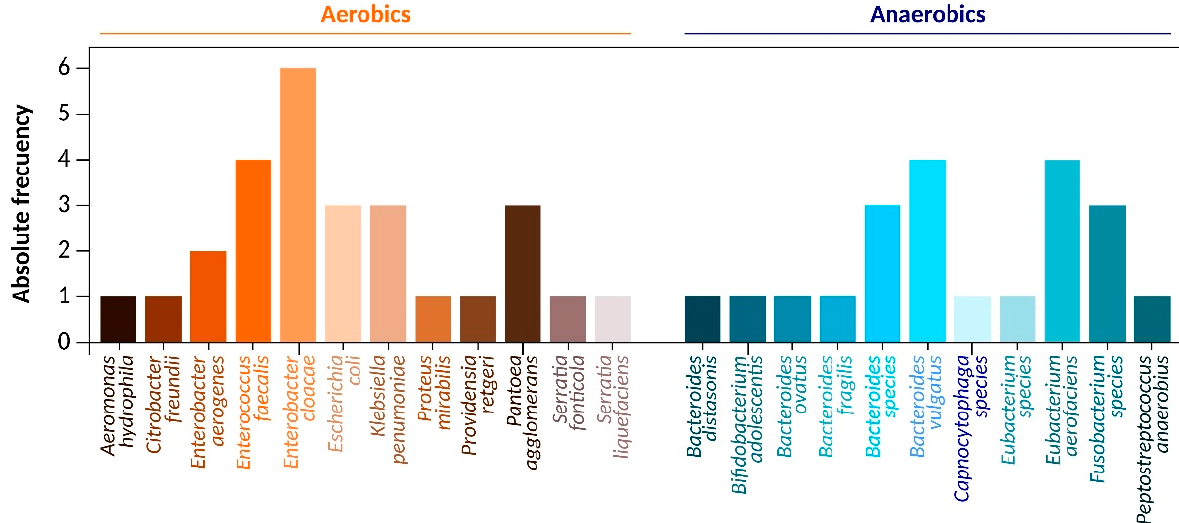
Figure 1. Bacterial frequency. The graph shows the frequency of beta-Lactam resistant aerobic and anaerobic Enterobacteriaceae isolated from feces sample of medicine student in healthy conditions. Table 1. Metagenomic identification of the aerobic and anaerobic beta-lactam resistant bacteria isolated from feces cultures of humans in healthy conditions.